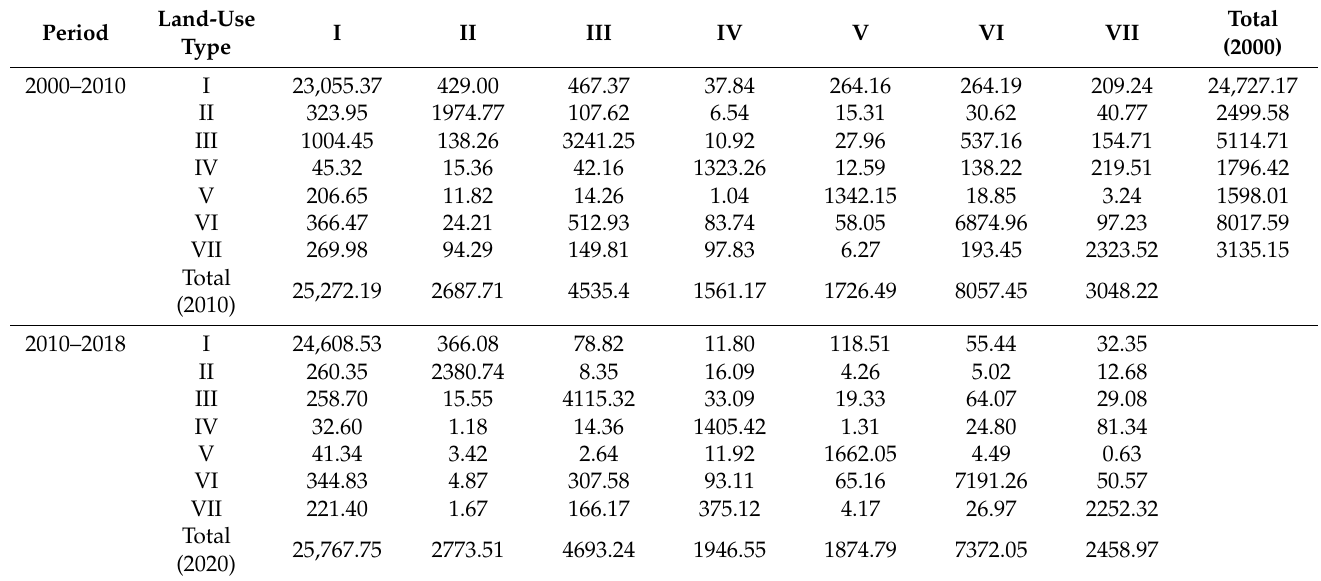
Table 3. Land-use transition matrix of western Jilin from 2000 to 2018 (km 2 ).